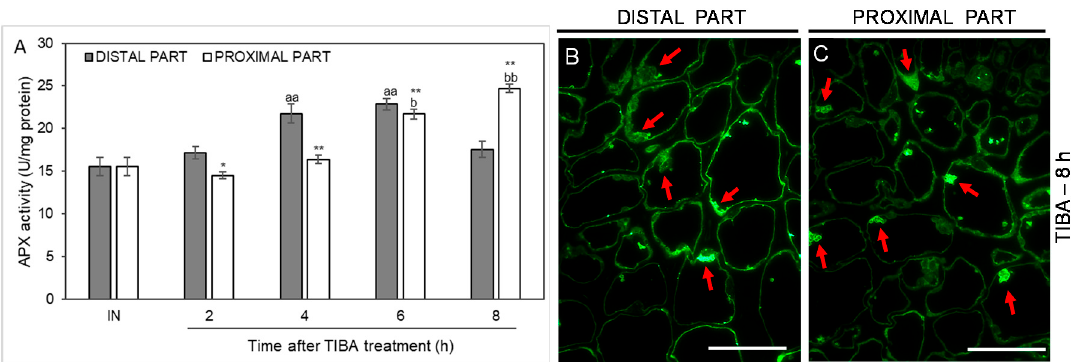
Figure 8. Time-course of ascorbate peroxidase (APX) activity and the enzyme localization in different regions of the AZ in response to the inhibition of polar auxin transport. Tween 20 solution (0.05%) was applied directly to the inactive AZ (IN) and material was collected after 8 h. An inhibitor of polar auxin transport, namely 2,3,5-triiodobenzoic acid (TIBA, 0.05 mM in 0.05% Tween 20), was also applied to the IN AZ and tissues were excised 2, 4, 6, and 8 h after treatment. APX activity was presented as the mean value of three biological replicates ( A ). Error bars indicate SEs. t -test: ** p < 0.01 and * p < 0.05, distal versus proximal part; aa p < 0.01, treated distal part versus inactive distal part; bb p < 0.01 and b p < 0.05, treated proximal part versus inactive proximal part. The localization of APX in the distal ( B ) and proximal ( C ) areas of the flower AZ. Observations were made 8 h after the TIBA application. The green fluorescence corresponds to APX presence (red arrowheads). Scale bars: 40 µM.